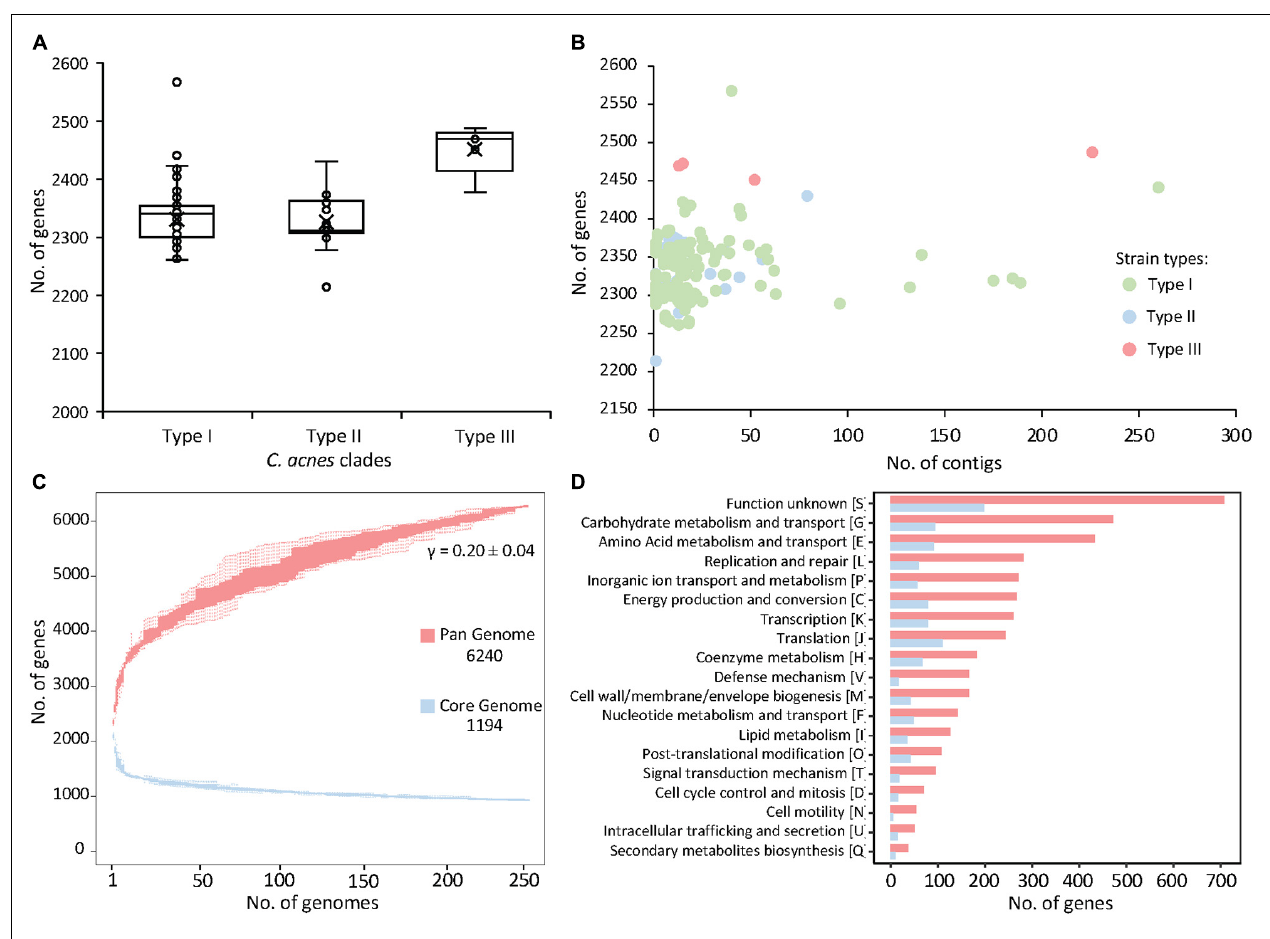
FIGURE 1 | Pan and core genome of the 255 Cutibacterium acnes . (A) Distribution of the number of genes per genome with C. acnes strains organized by clades. (B) Number of genes plotted against the number of contigs of the same genome. (C) The number of genes increases in the pan genome (red) and decreases in the core genome (blue) with the addition of more genomes. (D) Number of genes in the pan genome (red) and core genome (blue) corresponding to each functional category.